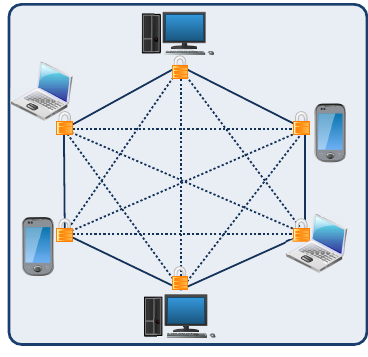
Figure 6. Private blockchain